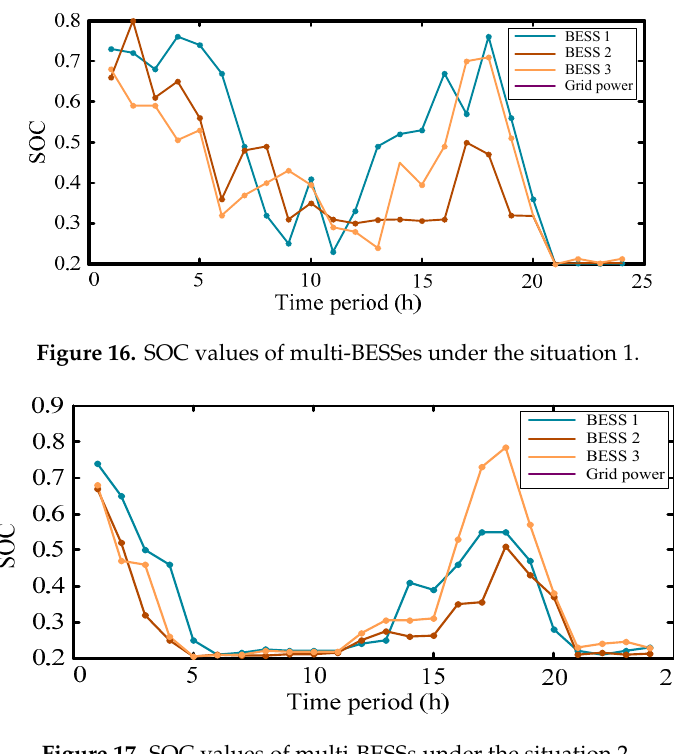
Figure 17. SOC values of multi-BESSs under the situation 2.